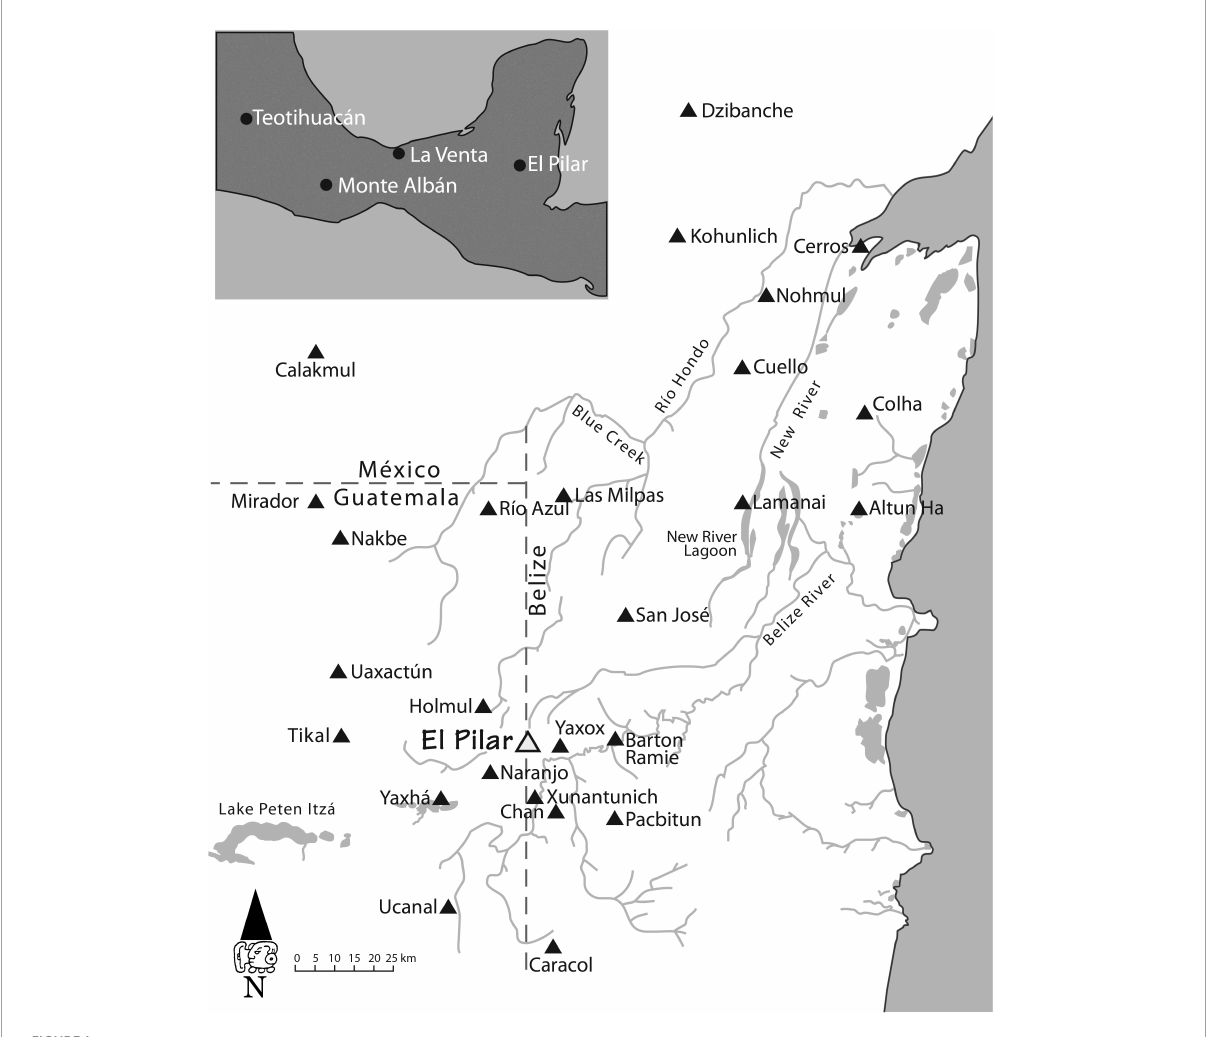
FIGURE1 Central Maya lowlands with major centers indicated. Credit MesoAmerican Research